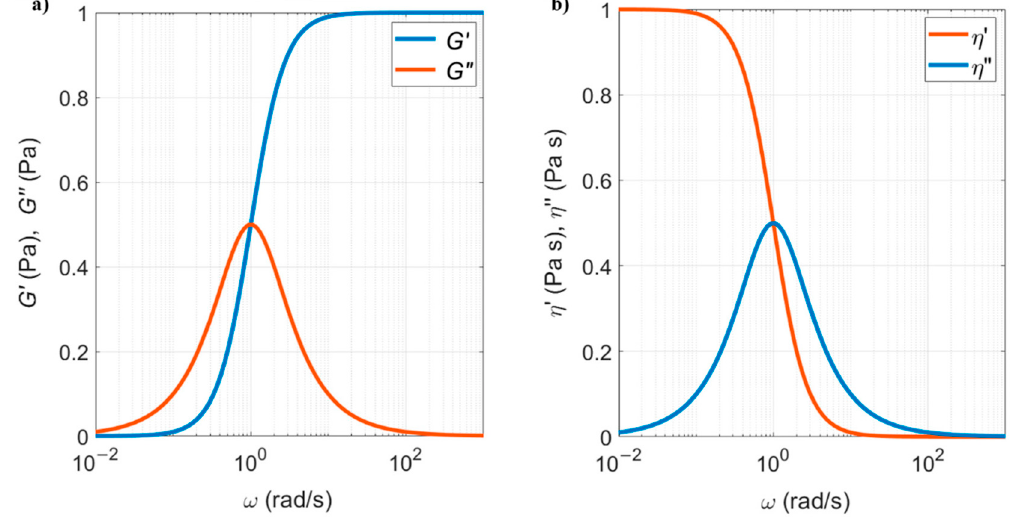
Figure 1. ( a ) Schematic of a cantilever beam of length L , width w , and thickness h . The cantilever is subjected to a distributed time-changing load per unit length, 𝑞(cid:4666)𝑥,𝑡(cid:4667) ; ( b ) longitudinal cross section of an infinitesimal element dx of the same cantilever (red part highlighted in ( a )), where the shear forces and bending moments act.